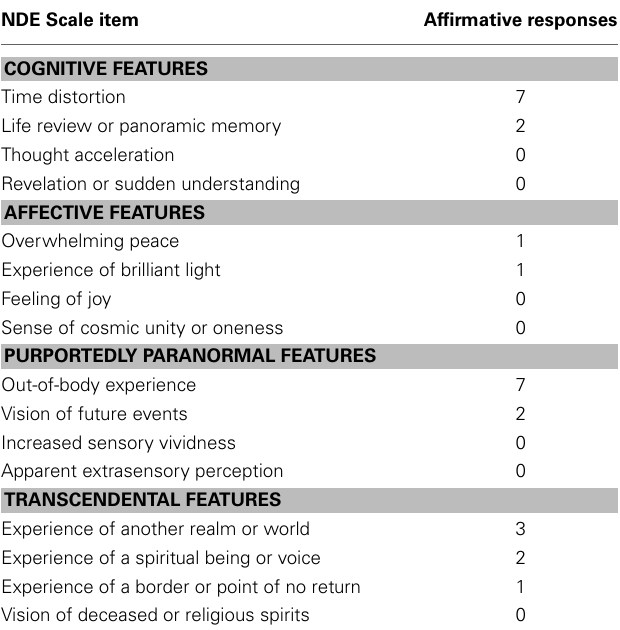
Table 1 | Frequency of affirmative responses to NDE Scale items associated with seizures ( N =